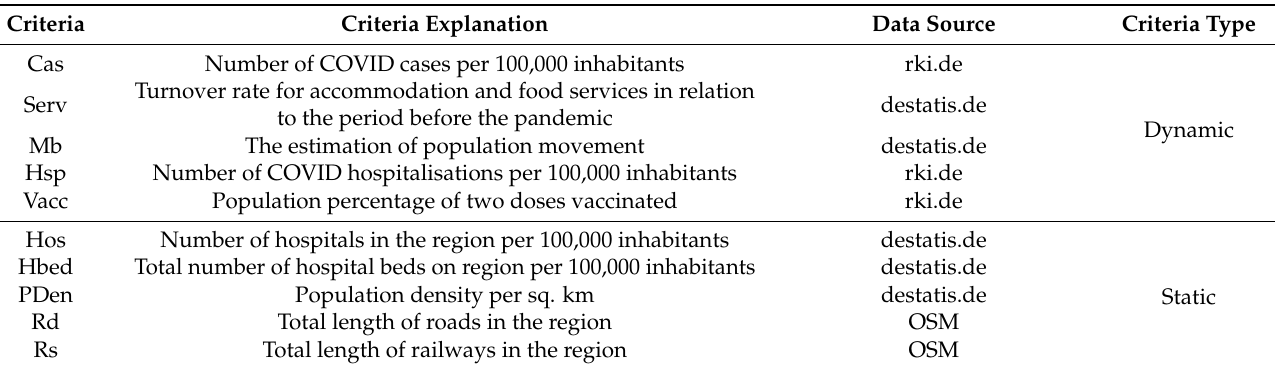
Table 1. SMCA criteria and criteria data sources (own